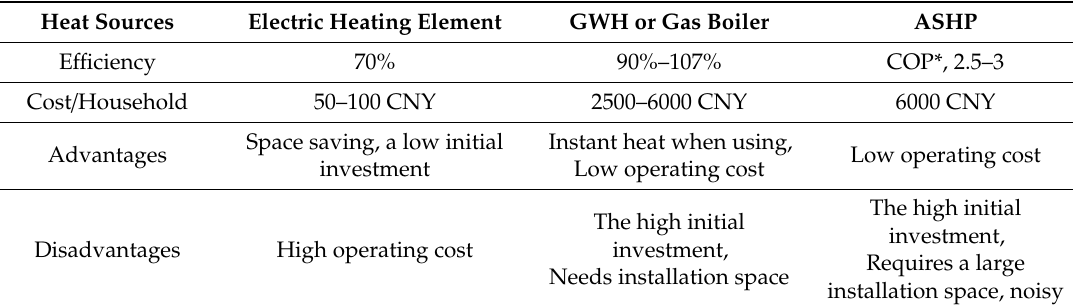
Table 7. A comparison of di ff erent types of auxiliary heat sources in individual household SWH